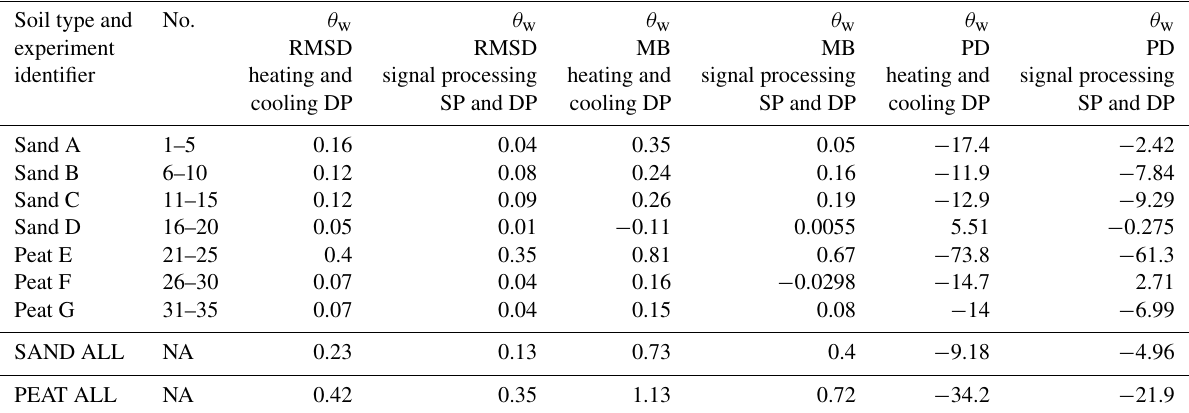
Figure 7. Thermal conductivity k and thermal diffusivity α for each of the experiments. (a) Thermal conductivity for sand. (b) Thermal conductivity for peat. (c) Thermal diffusivity for sand. (d) Thermal diffusivity for peat. Table 6. RMSD, MB, and PD comparisons for θ w